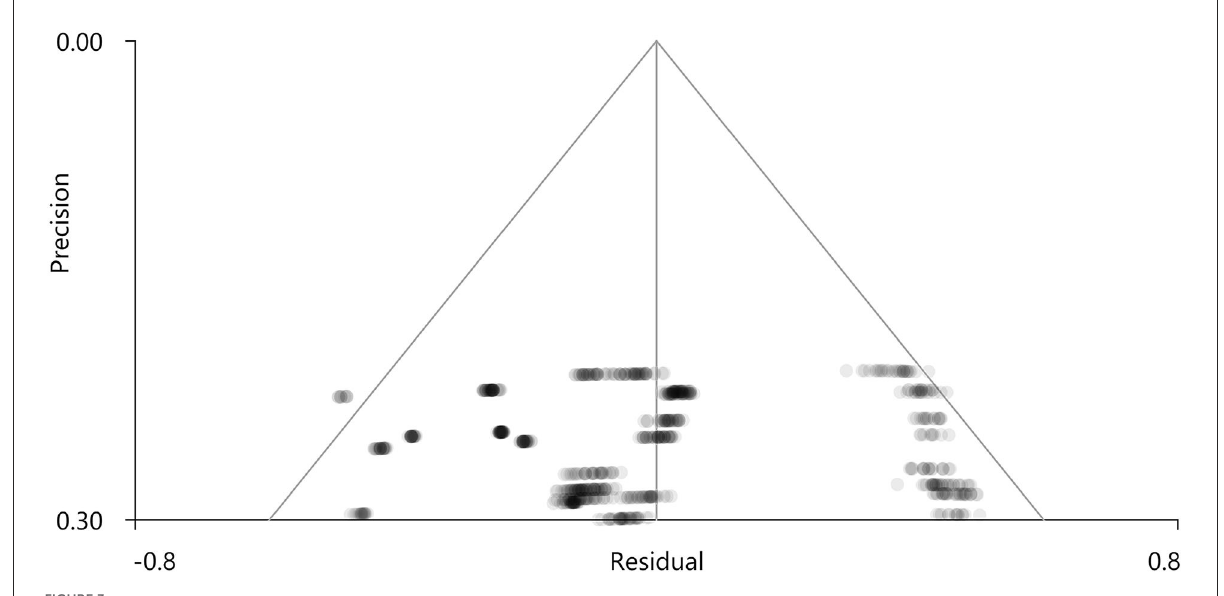
FIGURE3 Funnel plot of effect size of the right supramarginal